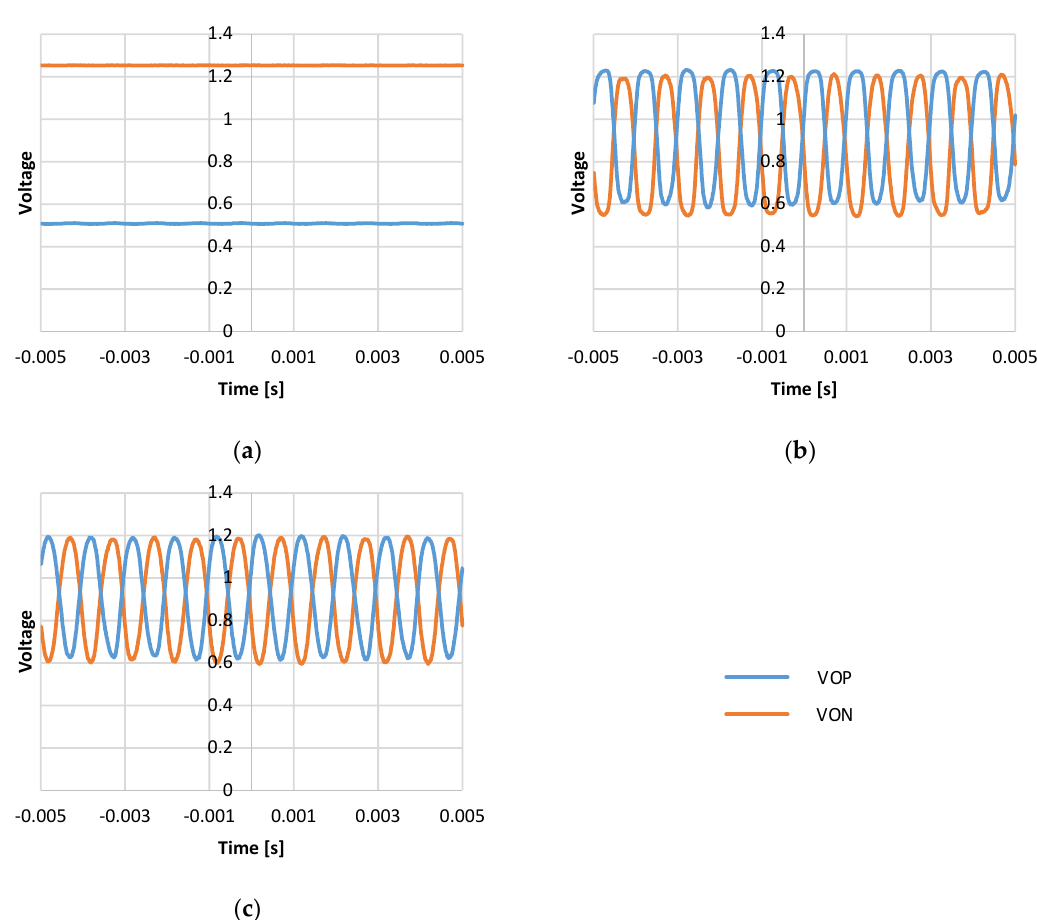
Figure 17. Output measurement with 1 g 1 kHz excitation for various offset trimming configuration: ( a ) Trimming capacitor with 8’b0000_0000 configuration; ( b ) trimming capacitor with 8’b1111_1111 configuration; and ( c ) trimming capacitor with 8’b1001_0000 configuration.